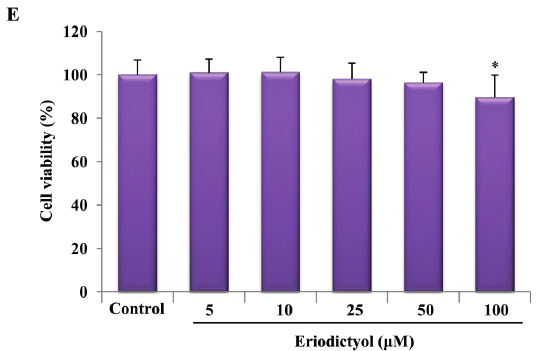
Figure 2. Upregulation of HO-1 by eriodictyol in HUVECs. Cells were treated with the indicated concentrations of eriodictyol (5, 10, and 20 μ M) for 18 ( A ) and 1 h ( B ), and HO-1 levels were measured by Western blot and RT-PCR. GAPDH (glyceraldehyde 3-phosphate dehydrogenase) served as a loading control; ( C , D ) Cells were treated with 10 μ M eriodictyol for the indicated times, and HO-1 levels were measured by Western blot and RT-PCR; and ( E ) Cell viability was estimated by MTT method. Data represents the mean ± SD of results in three independent experiments. * p < 0.05 vs . control group.